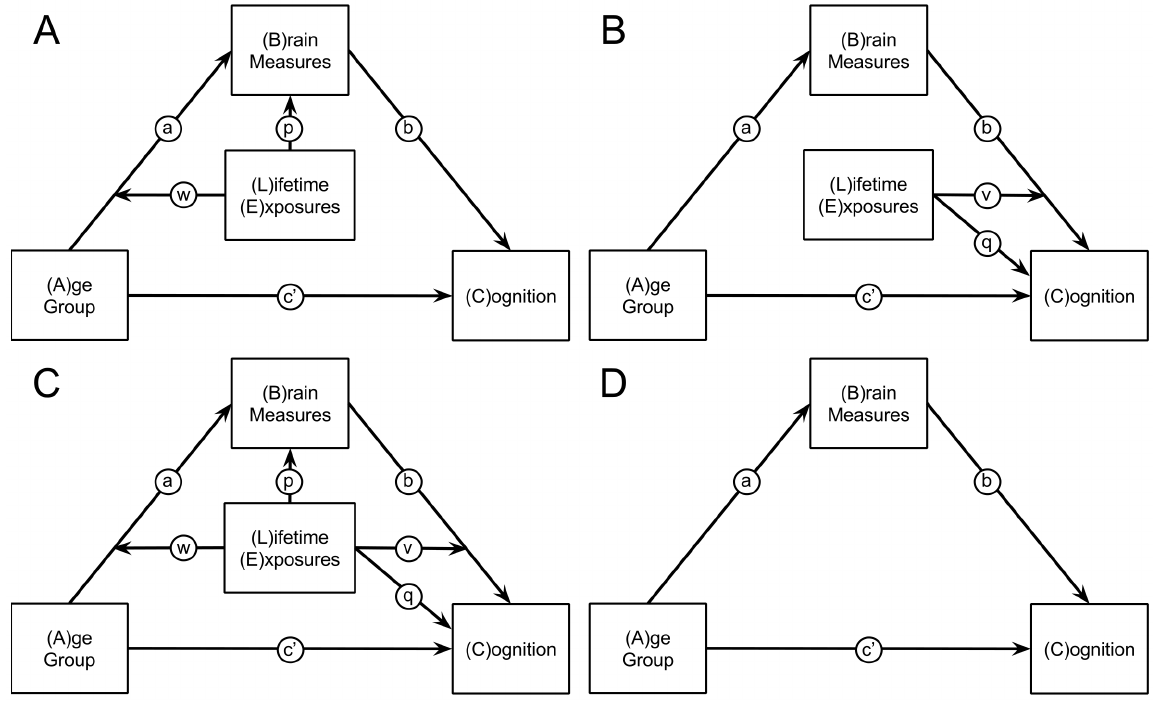
Figure 1. A–D: Structural models testing for the role of lifetime exposures (LE). The letters labeling each arrow in the figure correspond to the parameters in the equations and column headings in the tables of results. The models testing whether LE: A) decreased the effect of advancing age on neural measures, B) decreased the effect of age-related declines in neural measures on cognitive abilities, C) had both of these effects or D) had no effect.